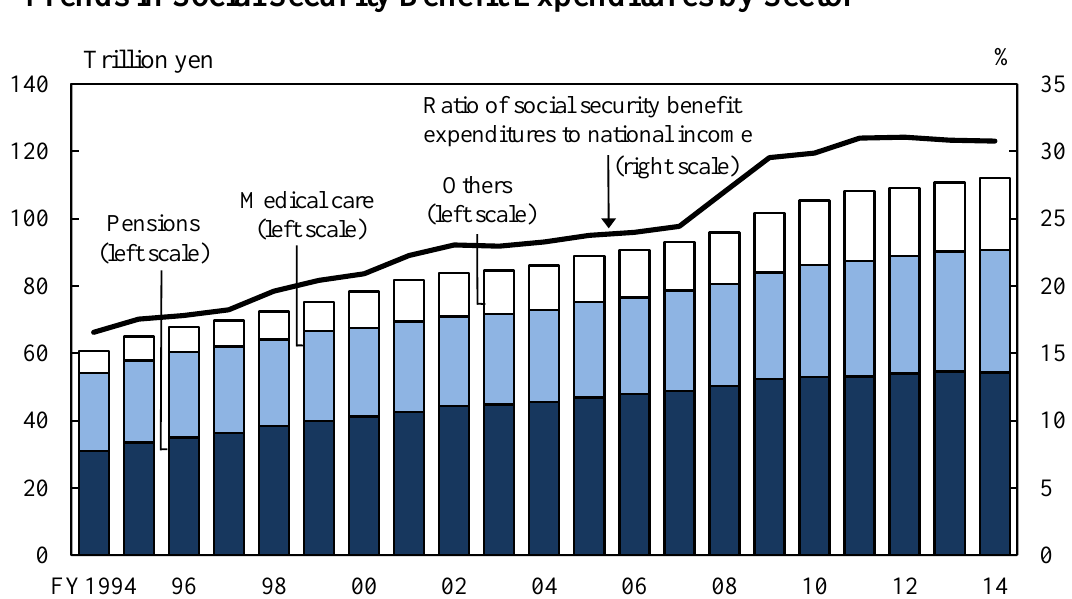
Figure 15.1 Figure 13.1 Trends in Social Security Benefit Expenditures by Trends in Social Security Expenditures